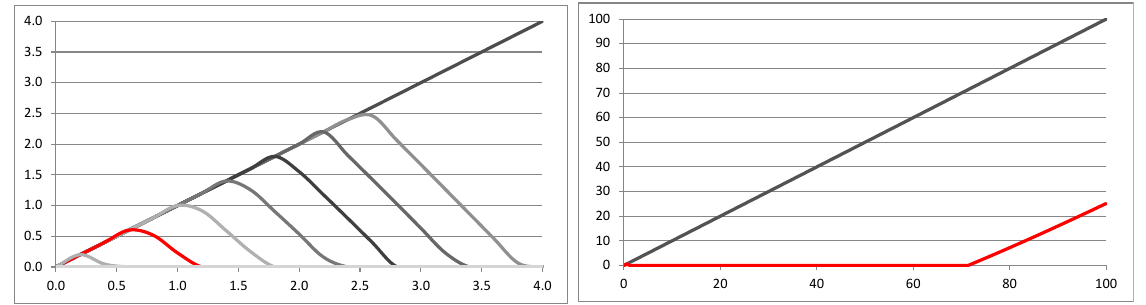
Figure 5. Case of small individual risk aversion parameter α = 0 . 01 < β = 0 . 0301 : the red line illustrates the optimal insurance cover x (cid:55)→ I ∗ ( x ) = I ( x, λ ∗ ( P ∗ ))